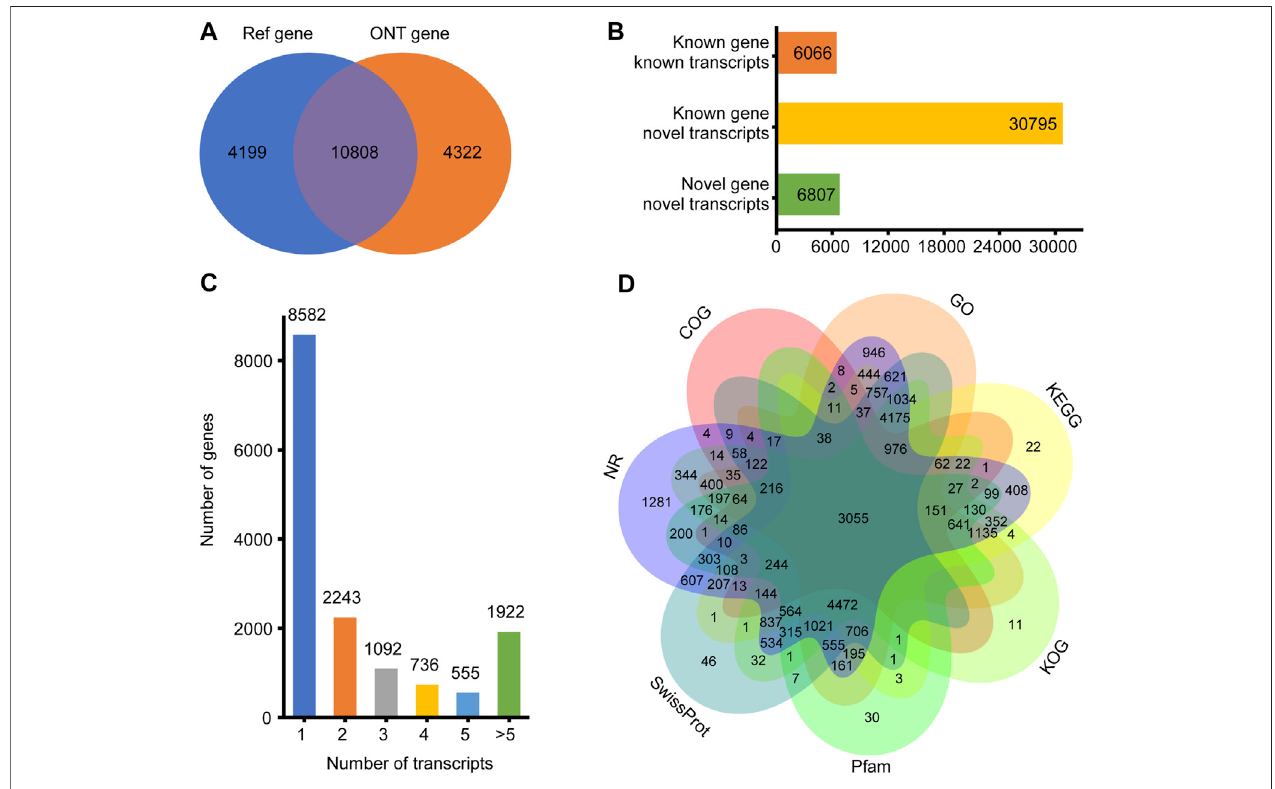
FIGURE 1 | Overview of ONT transcripts. (A) Venn diagram of genes identi fi ed in ONT data and annotated genomes; (B) Distribution diagram of three types of transcripts in ONT data; (C) Distribution diagram of gene multi-transcripts; (D) Venn diagram of all new transcripts annotation